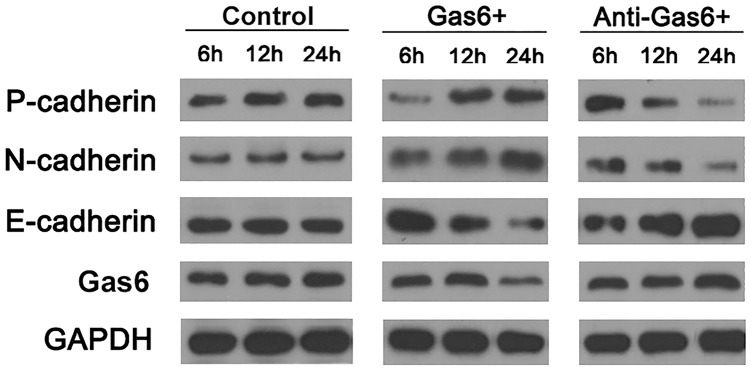
P-cadherin, N-cadherin, and E-cadherin expression in YD38 cells upon hrGas6 and block/neutralizing Gas6 antibody incubation.